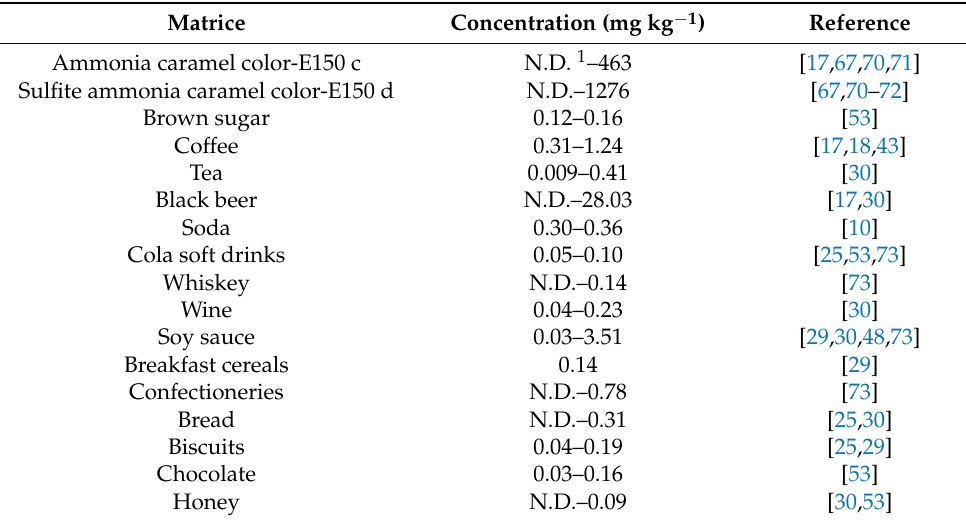
Table 1. Content of 4(5)-methylimidazole in caramel colors and food